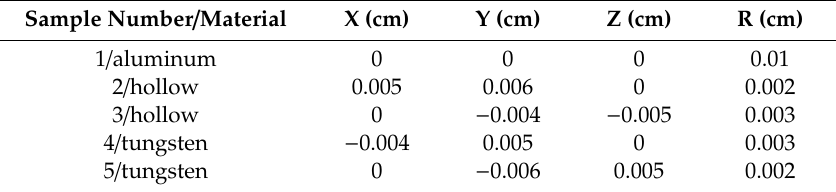
Figure 5. The complicated sample used for TDHEER simulation studies, ( a ) the sample structures with four small balls inside, ( b ) the reverse projection in the x - y plane, and ( c ) the HEER image of the sample with 0-degree rotation. Table 4. The positions and material parameters of the complicated spherical sample with four small balls inside.